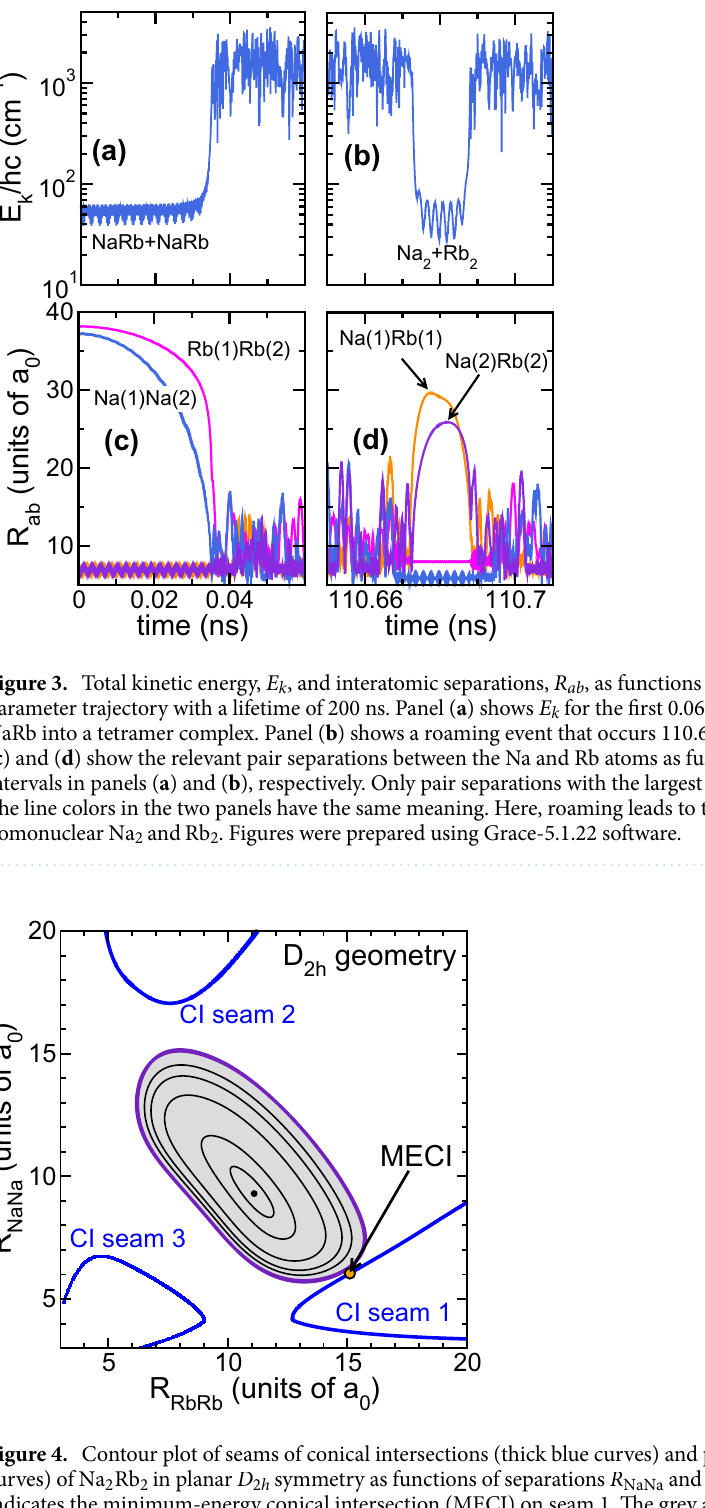
and electric dipole moments. Instead, we use density functional theory (DFT) to obtain the on-the-fly ground- state potential, as the four atoms classically evolve under the forces due to this potential, and time-dependent density functional theory (TD-DFT) to compute splittings between ground- and excited-state potentials as well as transition dipole moments. A description of these electronic-structure calculations is given in Methods.